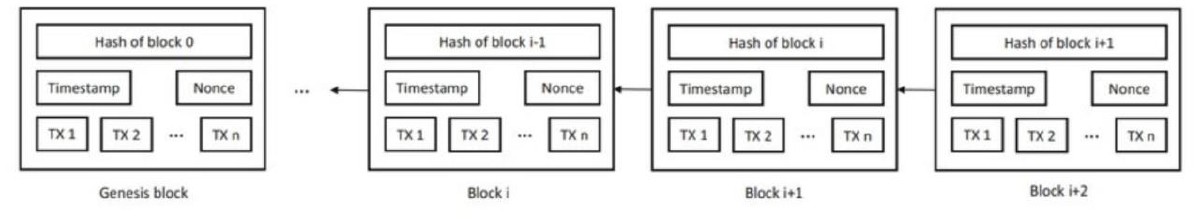
Figure 1: An example of blockchain which consists of a continuous sequence of blocks.